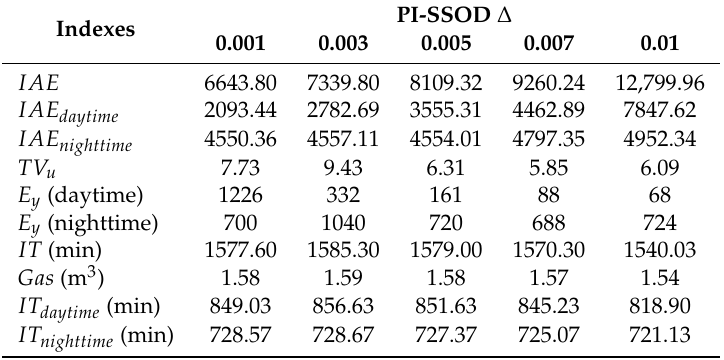
Table 3. Performance Proportional-Integral-Symmetric-Send-On-Delta (PI-SSOD)